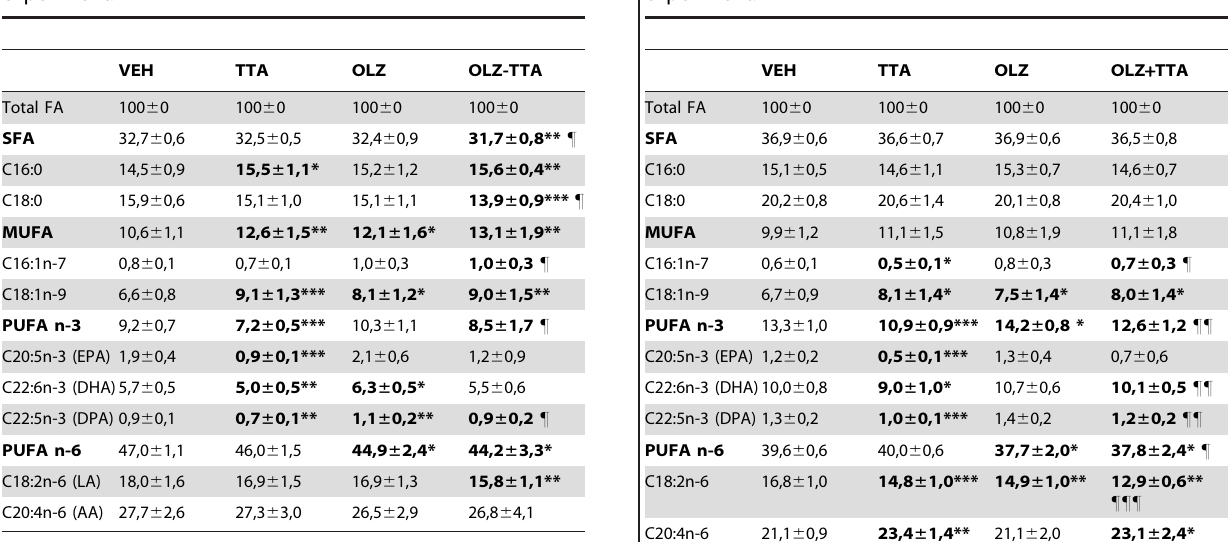
Table 3. Lipid subspecies in the liver in the subchronic experiment.